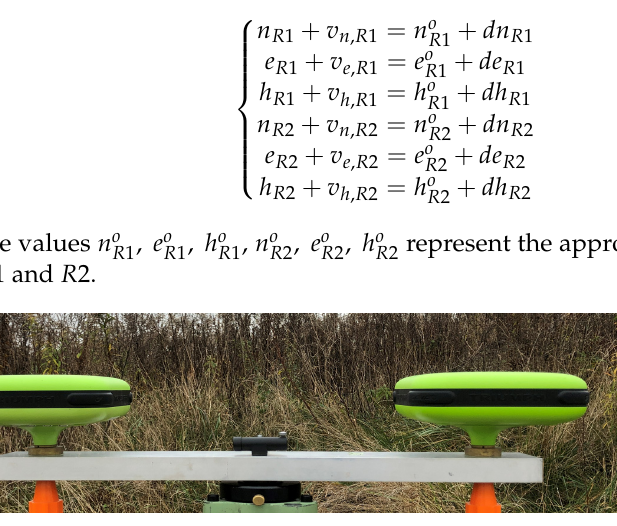
Figure 3. Javad TRIUMPH-1 receivers taking part in the experiment.